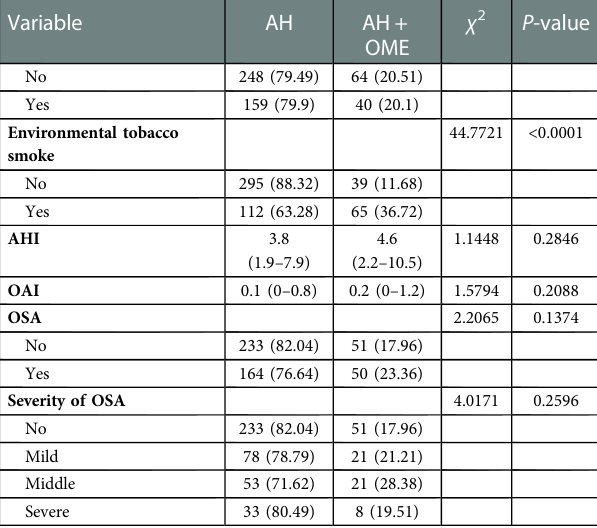
TABLE 1 Results of the univariate analysis of pediatric patients with adenoid hypertrophy with otitis media with